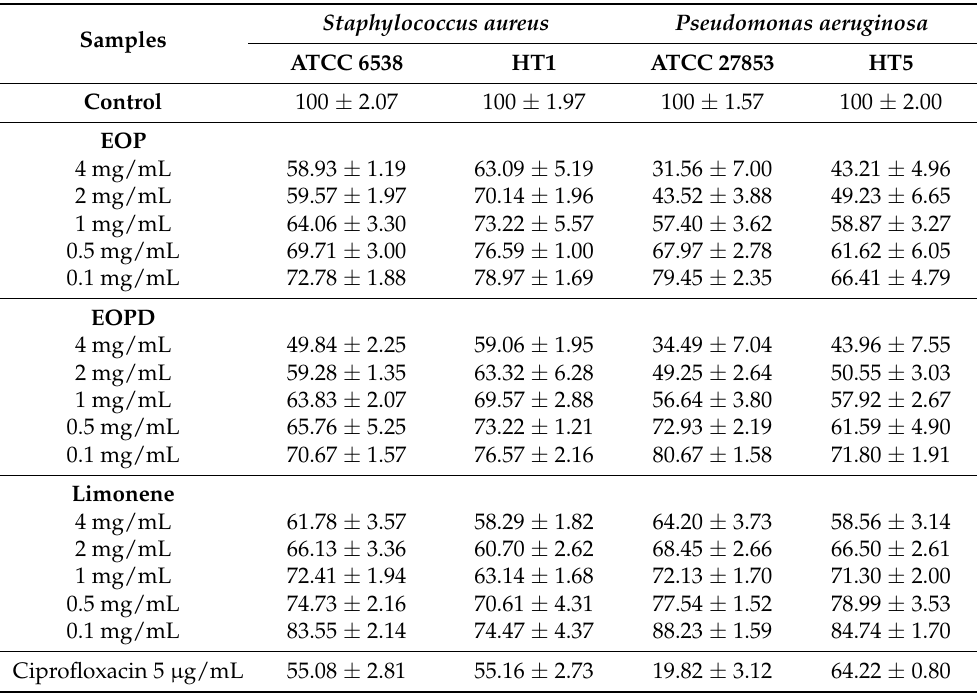
Table 3. Biofilm metabolic activity (%) rates of Staphylococcus aureus and Pseudomonas aeruginosa